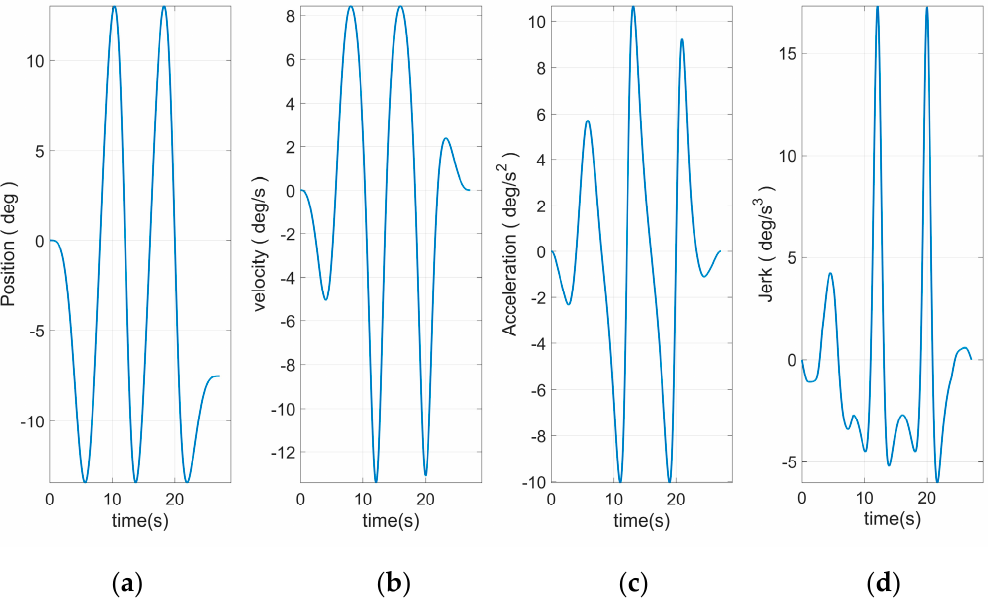
Figure 11. ( a ) Displacement of axis I over time. ( b ) Velocity of axis I over time. ( c ) Acceleration of axis I Figure 11. (a) Displacement of axis I over time. (b) Velocity of axis I over time. (c) Acceleration of axis over time. ( d ) Jerk of axis I over I over time. (d) Jerk of axis I over time.